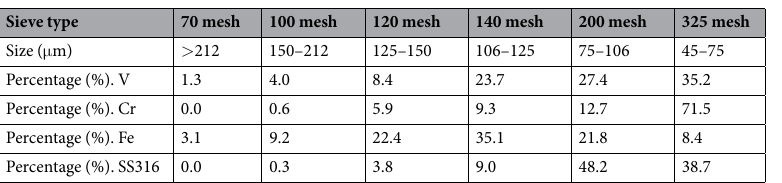
Table 2. Sieve analysis of V, Cr, Fe, and SS316 powder.